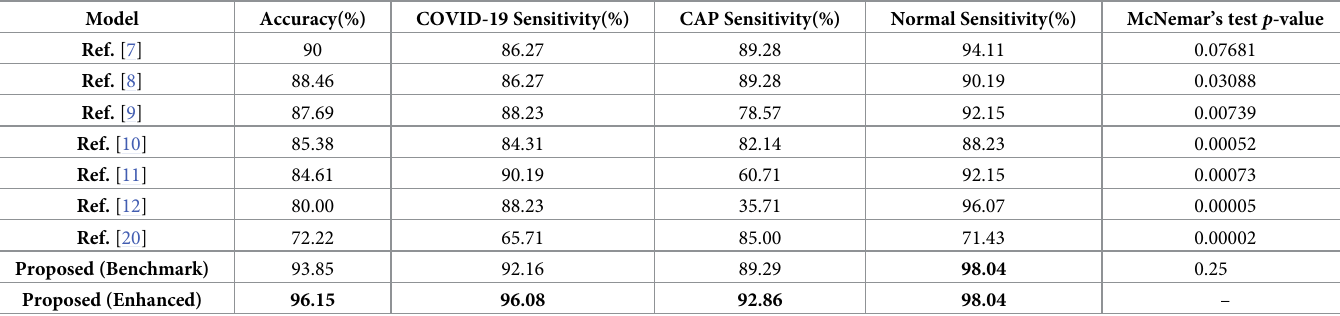
P -values for the McNemar’s test with the significance level of 0.05 are presented in the last column comparing the proportion of errors on the entire test sets obtained by our proposed framework and other models.